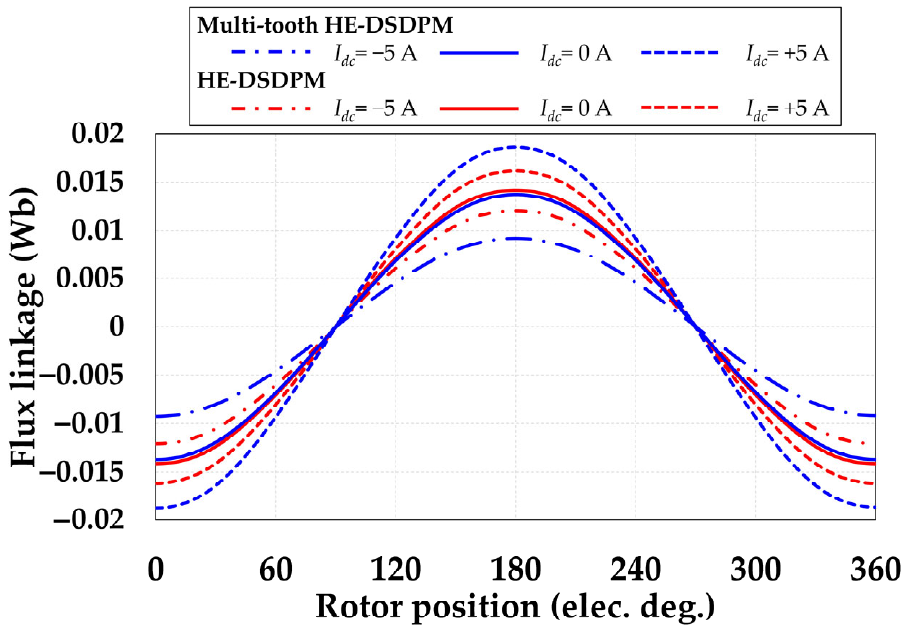
Figure 7. Open ‐ circuit flux linkage of the proposed HE ‐ DSDPM with various I dc . Figure 7. Open-circuit flux linkage of the proposed HE-DSDPM with various I dc